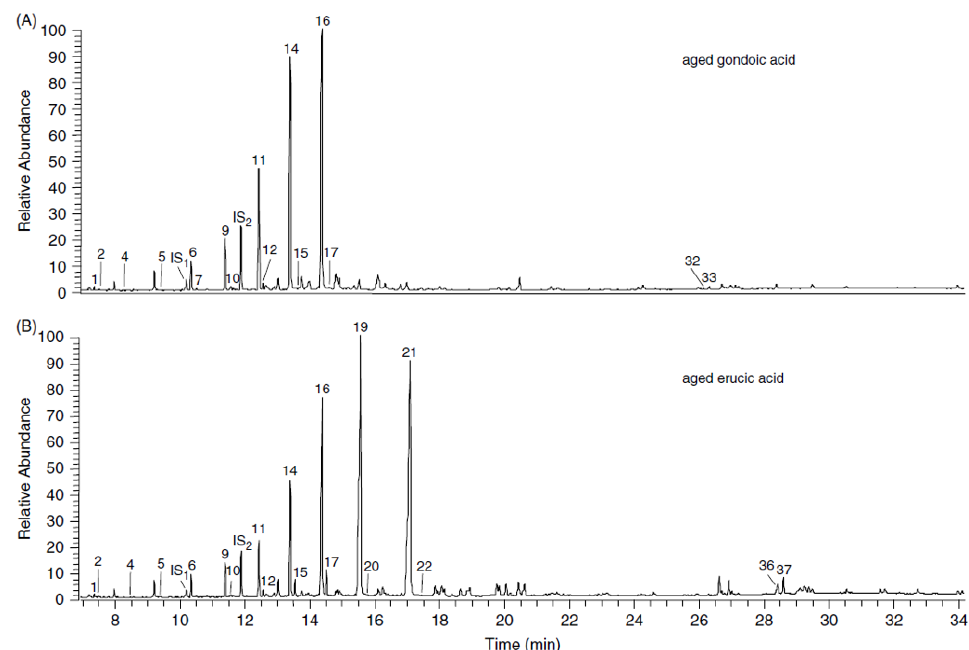
Figure 3. GC–MS chromatogram of aged gondoic ( A ) and erucic ( B ) acid standards. Reprinted with the permission from Ref. [91]. Copyright 2005 John Wiley and Sons, Ltd. Peak assignment is de-